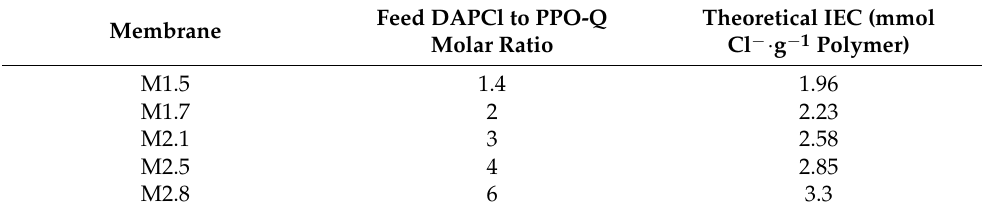
Table 1. Monomer to polymer ratio and theoretical IEC of the membranes.